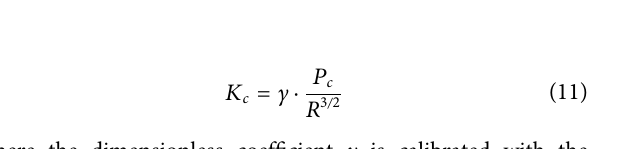
FIGURE 8 | The schematic diagrams of the methods to evaluate fracture toughness at small